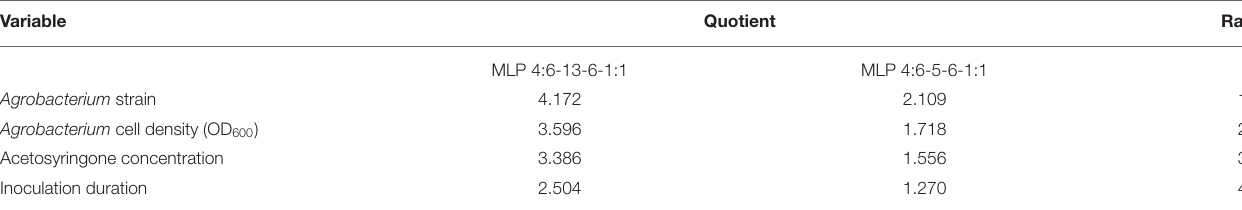
TABLE 5 | The sensitivity analysis of the governing variables on the percentage of putative and PCR-verified transgenic tobacco plants. Variable